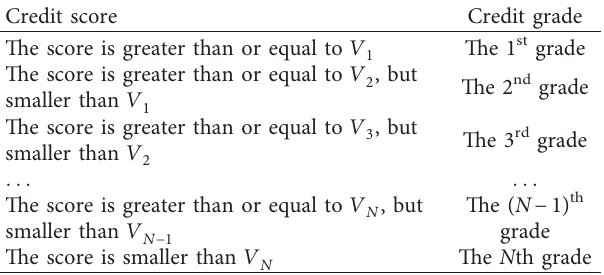
Table 1: The rules of farmers’ credit